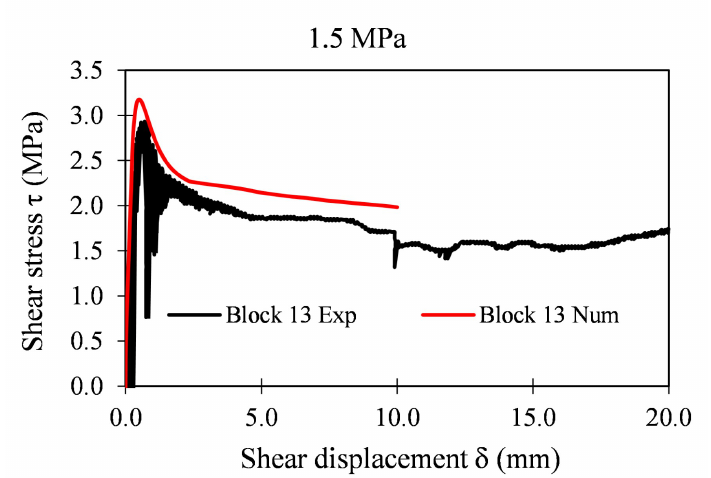
Figure 34. Shear stress evolution with displacement Exp–Num (Block 13).